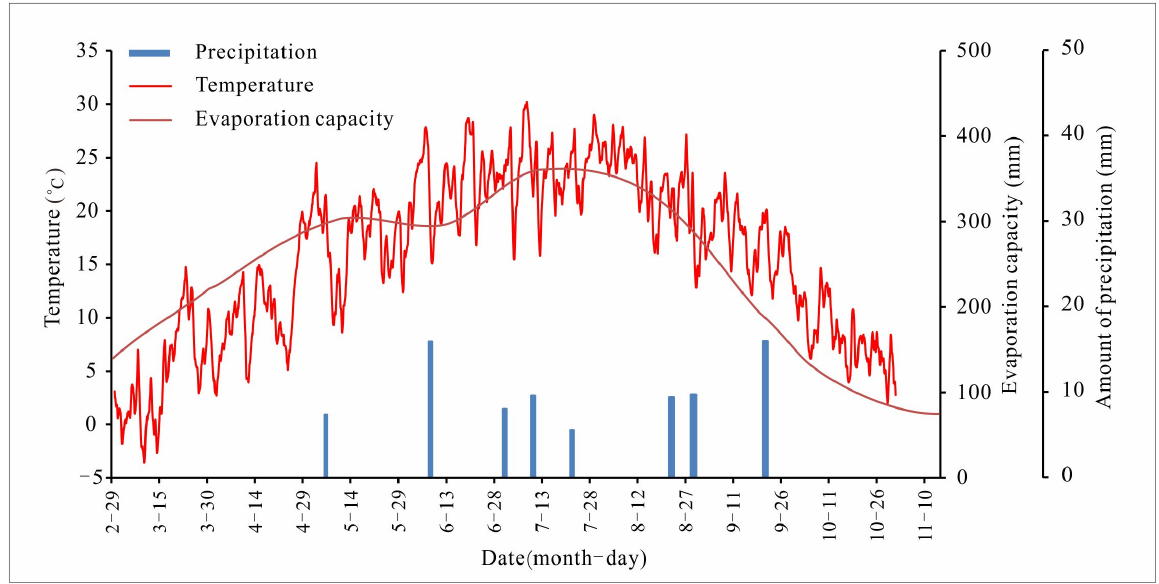
Figure 18. Main meteorological elements changes in 2020 in experimental base.